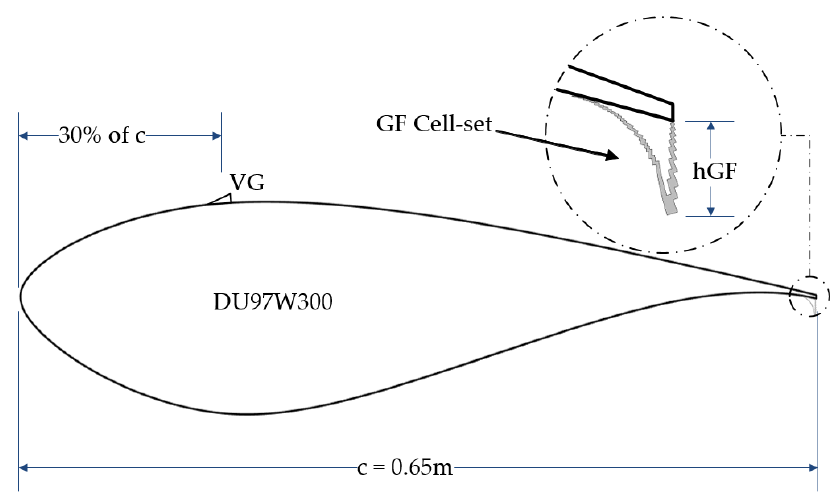
Figure 3. Sketch of the vortex generator (VG) (jBAY) and the GF (cell-set) setup. Chord value of c = 0.65 m, VG location at 30% of the chord length, and GF cell-set profile representation.